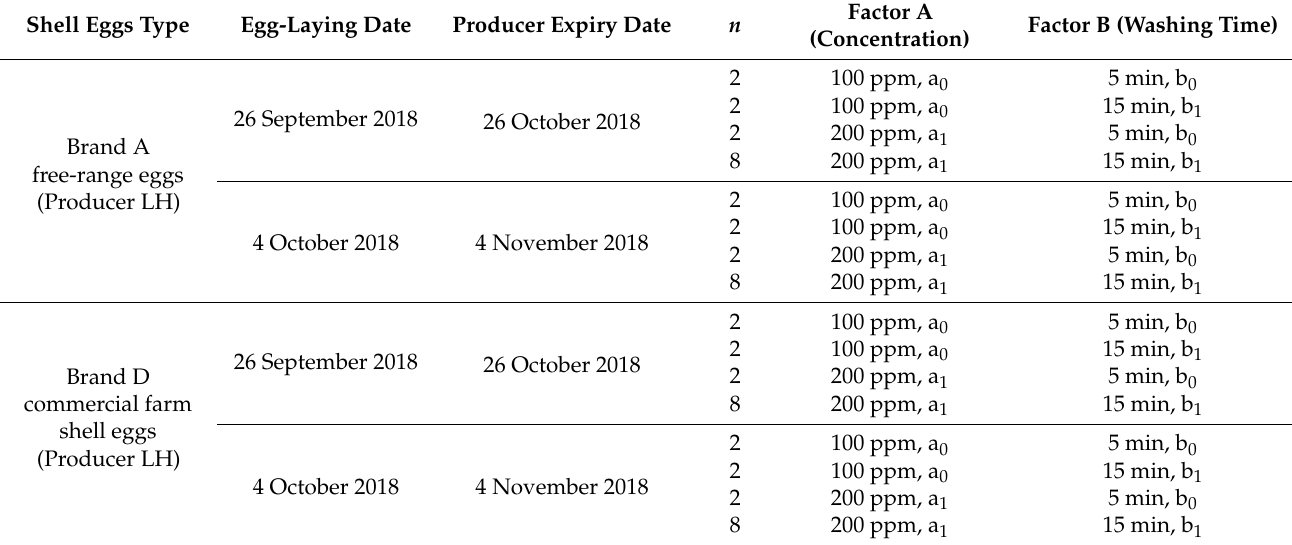
Table 2. Full (2 2 ) factorial experiment design for the free-range egg quat sanitizer treatment.